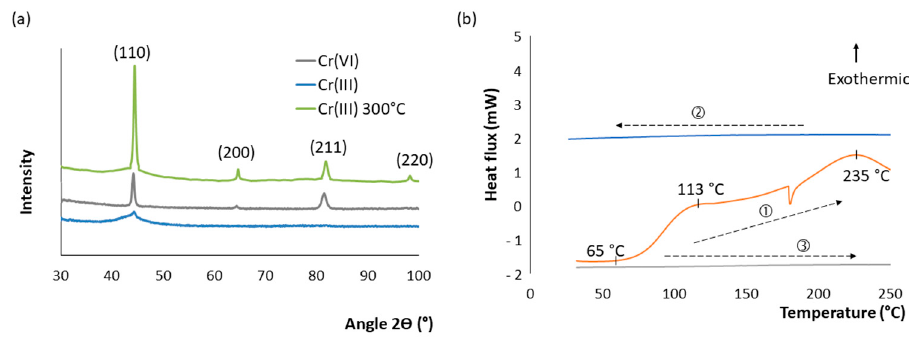
Figure 6. ( a ) X-ray diffractograms of trivalent chromium deposits raw and after a post-heat treatment at 300 °C. ( b ) DSC analysis of a rough trivalent chromium deposit.